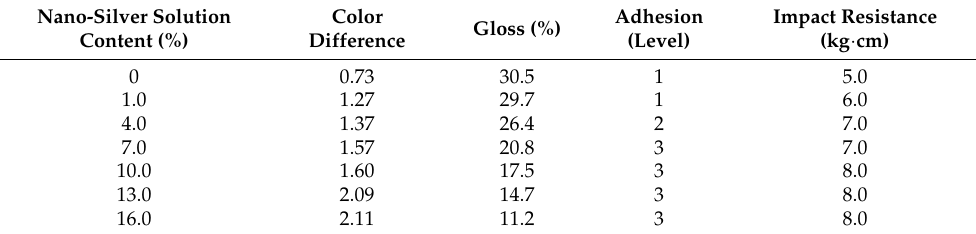
Table 4. Performance of primer film added with different concentrations of nano-silver solution.